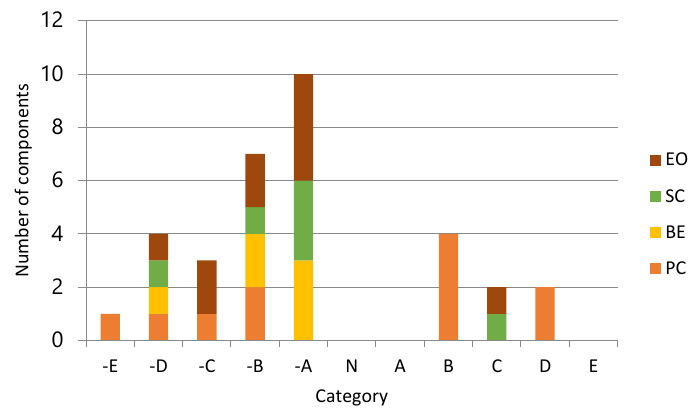
Fig. 5: Assessment of scenario 4 (incineration) by the RIAM method